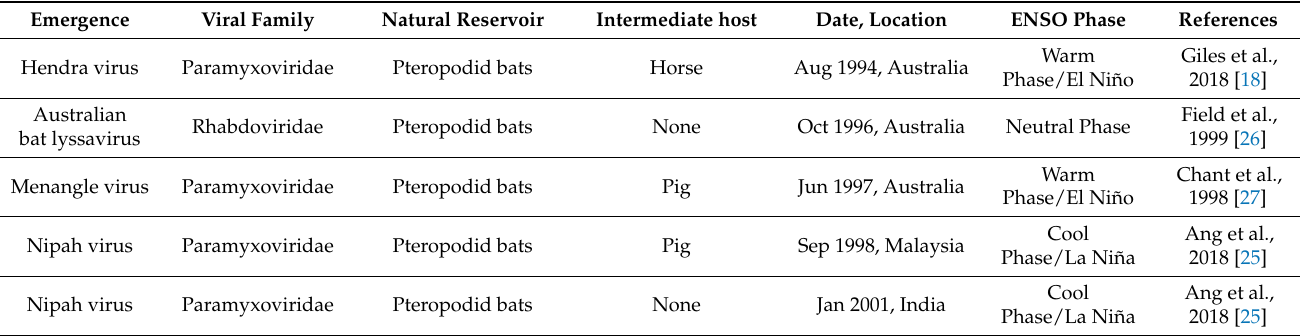
Table 1. Emergence of bat-borne viruses in the Asia–Pacific region and the Arabian Peninsula in relation to El Niño Southern Oscillation (ENSO)-driven climate anomalies (data on ENSO were retrieved from